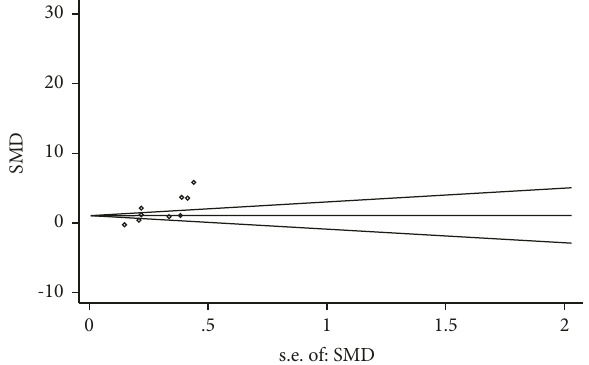
Figure 7: Publication bias via Begg’s test based on works of the literature providing the seminal leptin concentration (continuity- corrected: z � 3.27, p � 0 .